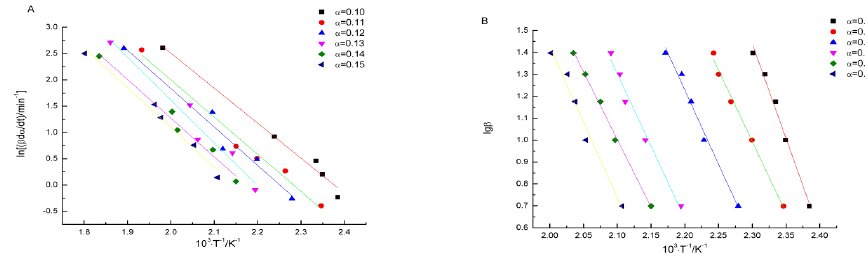
Figure 5. Fitting curves based on FRL ( A ) and FWO ( B ) methods. Table 4. Activation energy based on FRL and FWO methods.